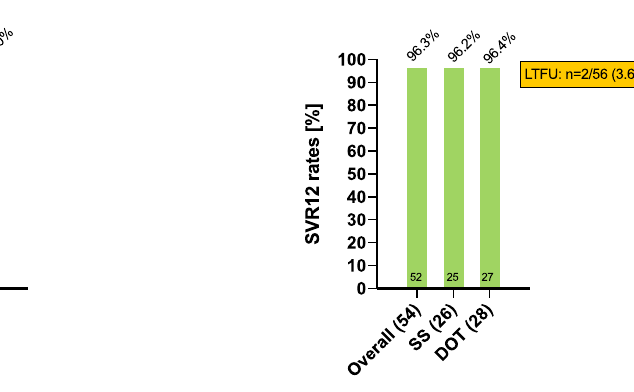
Fig 2. SVR12 rates after treatment with G/P according to mITT. Abbreviations: SVR, sustained virologic response; G/P, glecaprevir/pibrentasvir; mITT, modified intention-to-treat; SS, standard setting; DOT, directly observed therapy; LTFU, lost to follow-up; HCV, hepatitis C virus; GT, genotype. A—All patients (n = 141/145). a including one patient who died 16 weeks after end of therapy for reasons not related to treatment after showing a negative HCV-RNA PCR result three weeks after end of therapy. B—Patients with advanced fibrosis (n = 21/21). Advanced fibrosis was defined as F3-F4: � 9.5 kPa according to transient elastography. C—Patients with HCV GT3 infection (n =